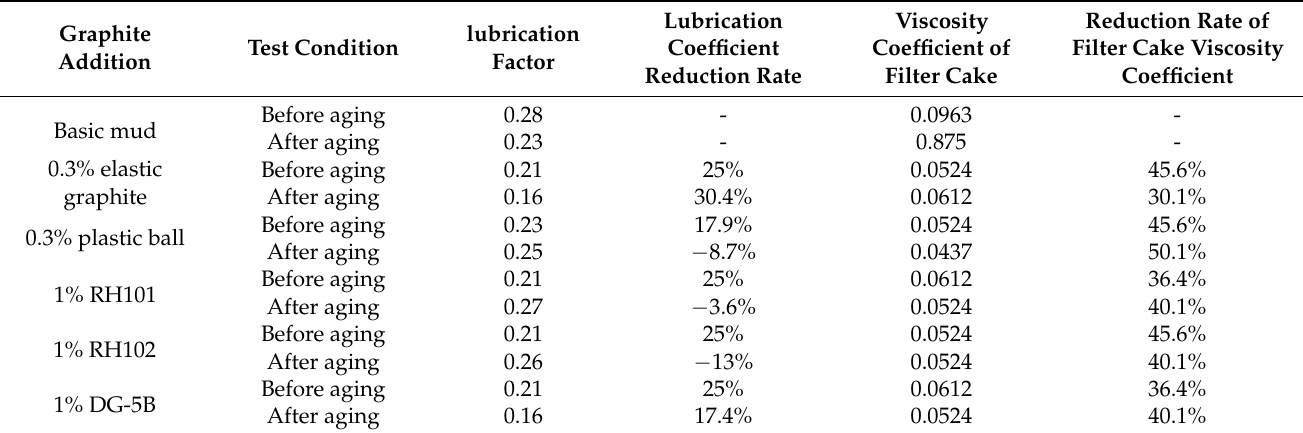
Table 10. Effects of different types of lubricants on the lubrication performance of drilling